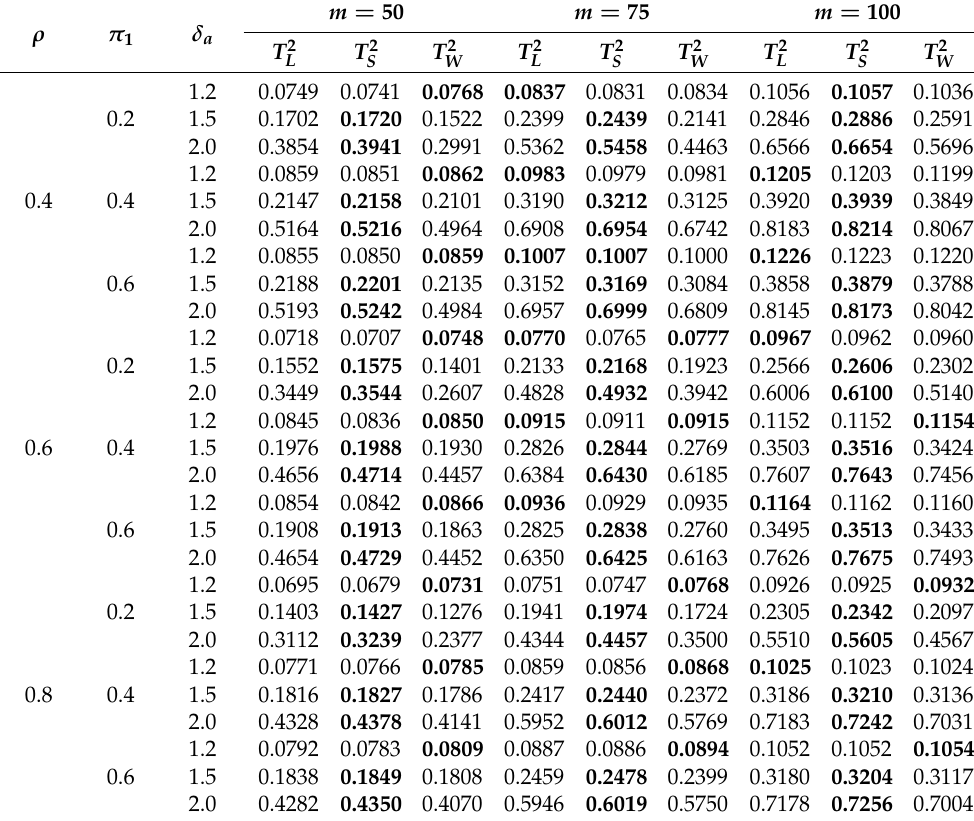
Table 3. Empirical powers of tests under H 0 : δ 0 = 1 vs. H a : δ a =